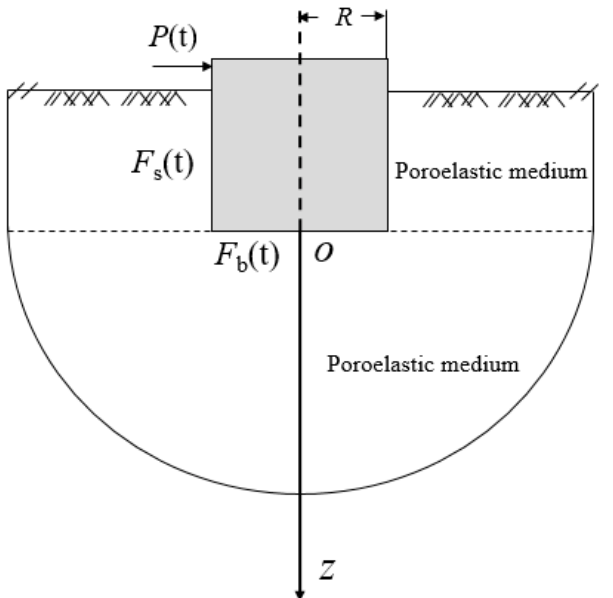
Figure 1. Rigid cylindrical foundation embedded in a poroelastic half-space.